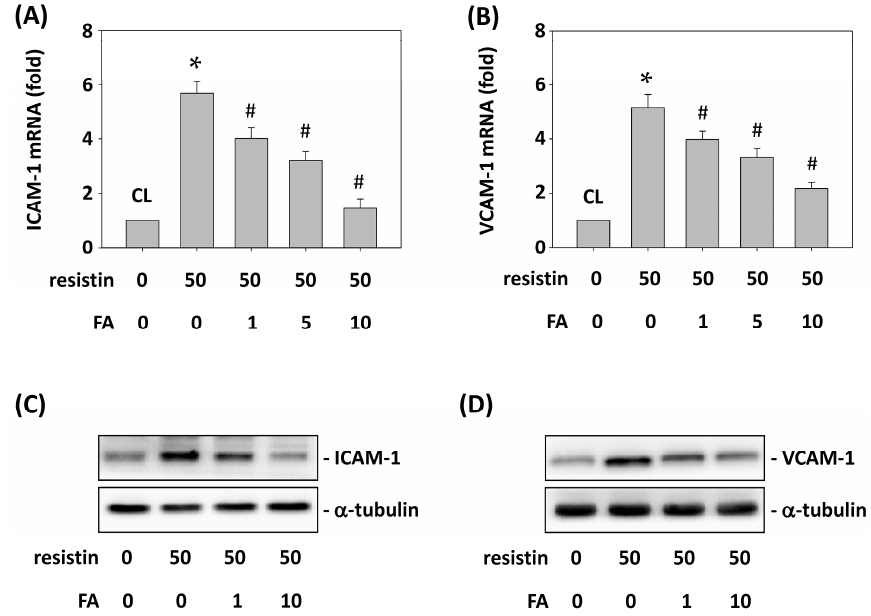
Figure 6. FA inhibits resistin-induced ICAM-1 and VCAM-1 expression in HCT-116 cells. HCT-116 cells were pretreated with FA at 0, 1, 5 and 10 μ g/mL and then were maintained as control or stimulated with resistin. ICAM-1 and VCAM-1 mRNA ( A , B ) and protein ( C , D ) expression was determined. Data in ( A , B ) represent the mean ± SEM from three independent experiments. The results in ( C , D ) are representative of three independent experiments with similar results. * p < 0.05 vs. control cells; # p < 0.05 vs. cells treated with resistin only.